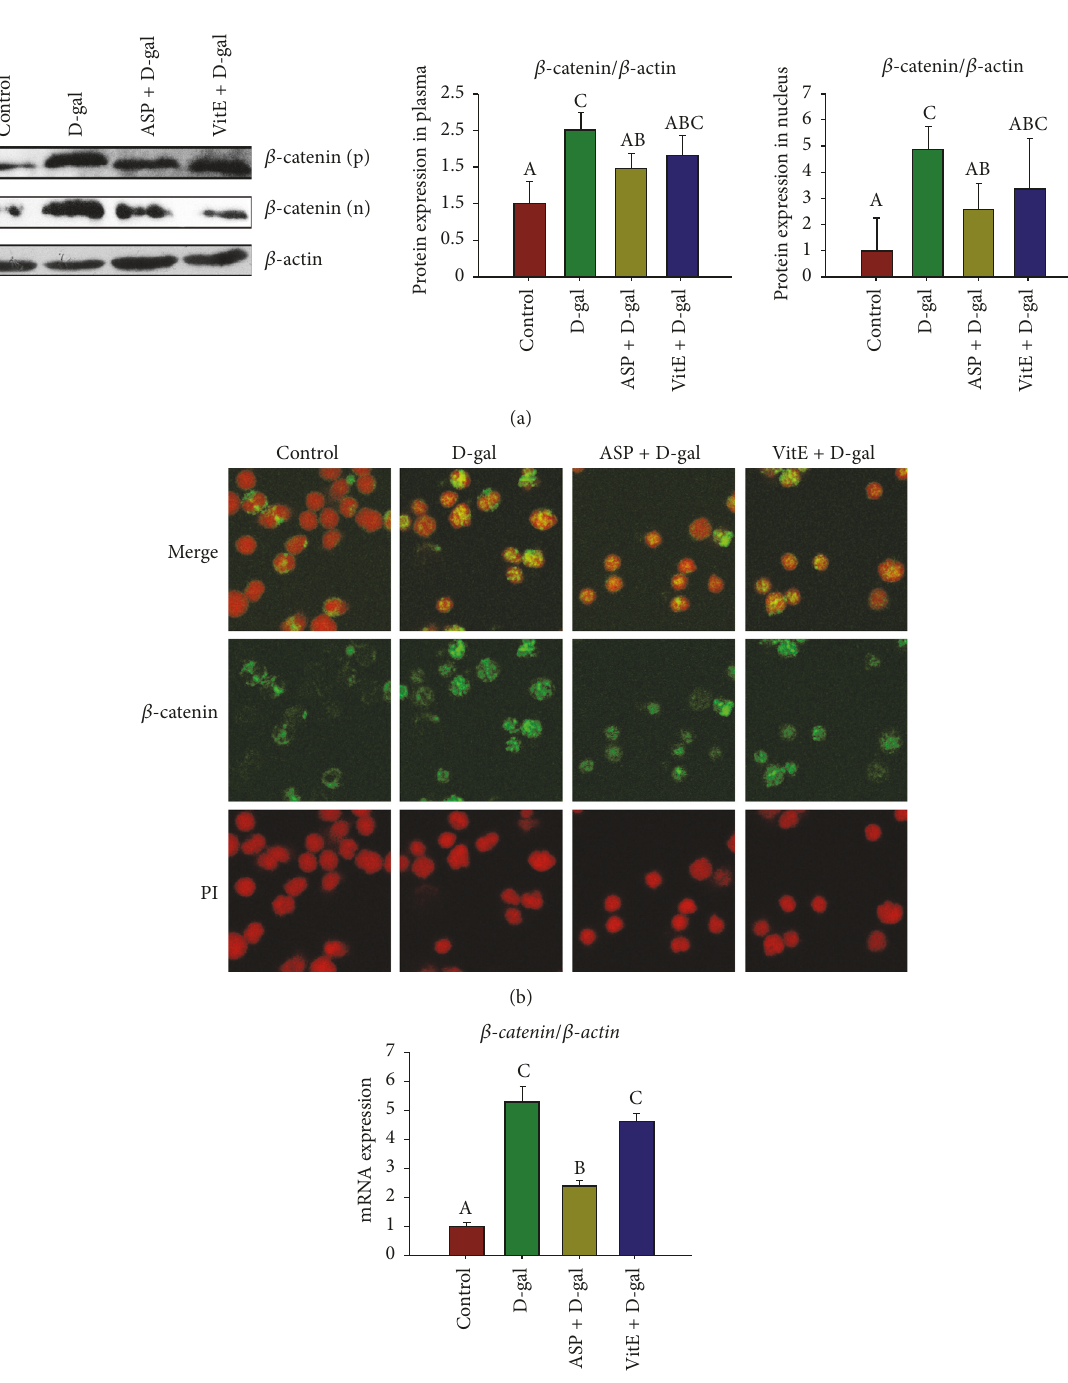
Figure 4: Effect of ASP on 𝛽 -catenin expression of Sca-1 + HSC/HPCs in D-gal- induced aging mice. The Sca-1+ HSC/HPCs were collected after the treatment. (a) The protein expression analyses of 𝛽 -catenin by Western blot. Proteins were extracted from cellular cytoplasm and nucleus, respectively; 𝛽 -actin was used as the internal control. (b) The cellular localization of 𝛽 -catenin by immunofluorescence, PI (red) to visualize nucleus. (c) 𝛽 -catenin mRNA expression by qRT-PCR, 𝛽 -actin was used as the internal control. Different letters: 𝑃 < 0.05